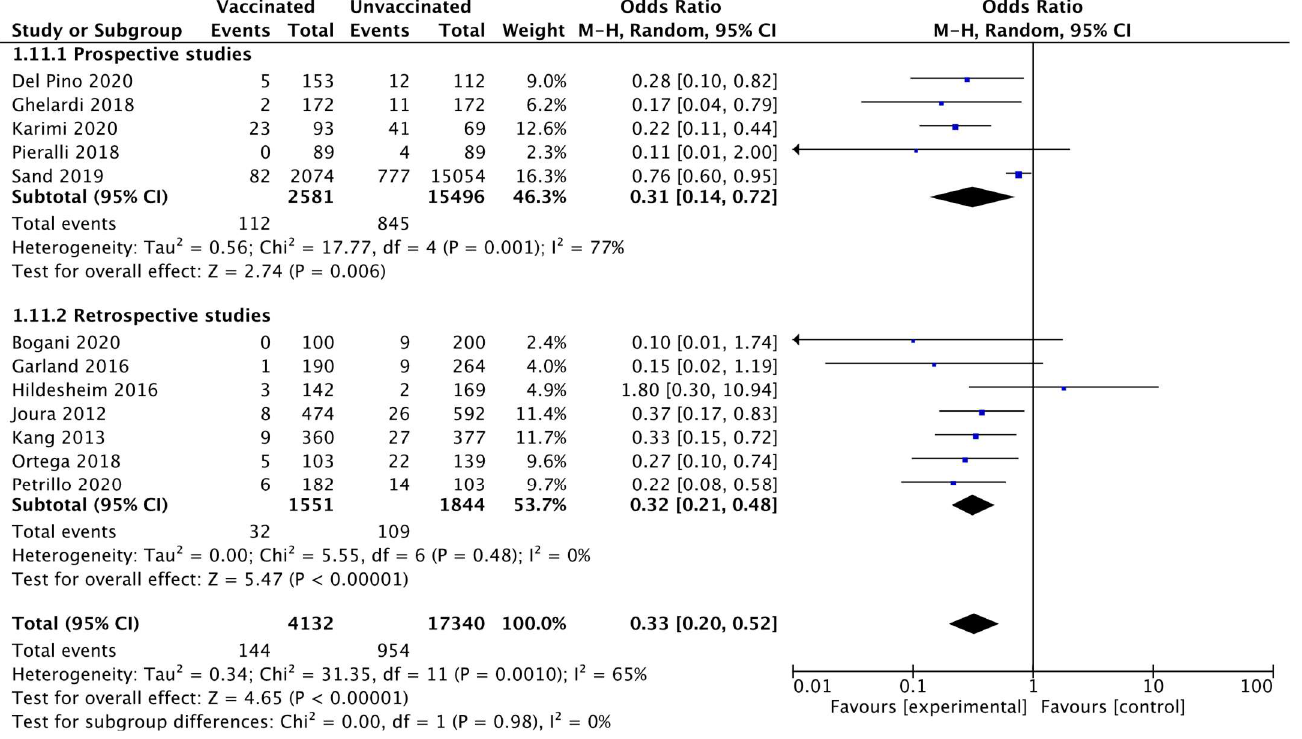
Figure 4. Forest plot of comparison: subgroup analysis related to the study design for CIN 2+ recur- rence.